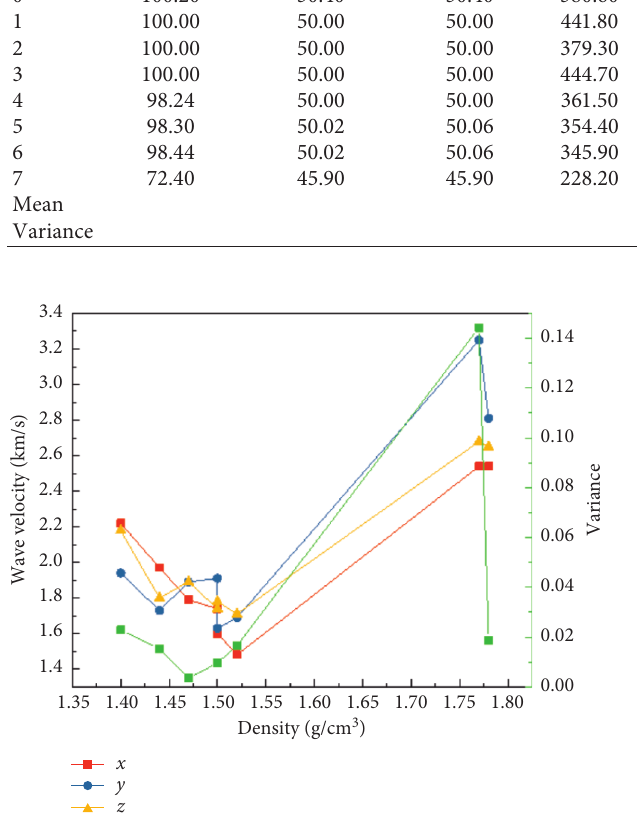
Figure 4: Density and ultrasonic wave velocity of coal.